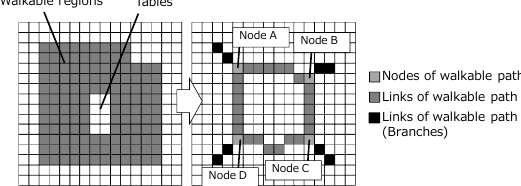
Figure 5. Walkable path generation from a walkable region (left: walkable region, right: walkable path)